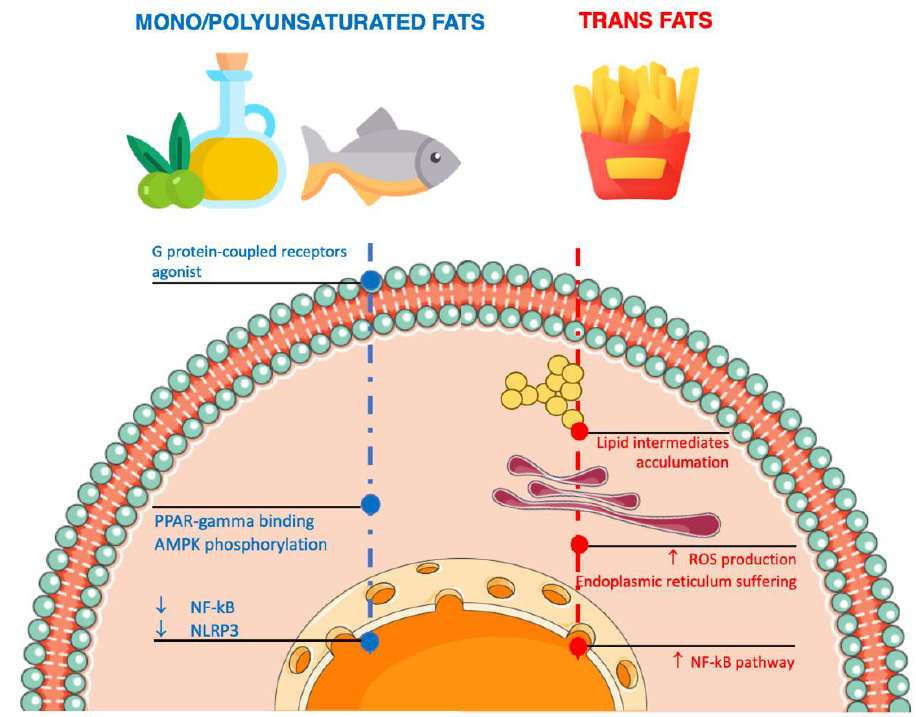
Figure 3. Mechanisms of action related to the inflammatory pathways of unsaturated fatty acids in adipocytes and macrophages. Arrows denote increment/increase or decrement/decrease.